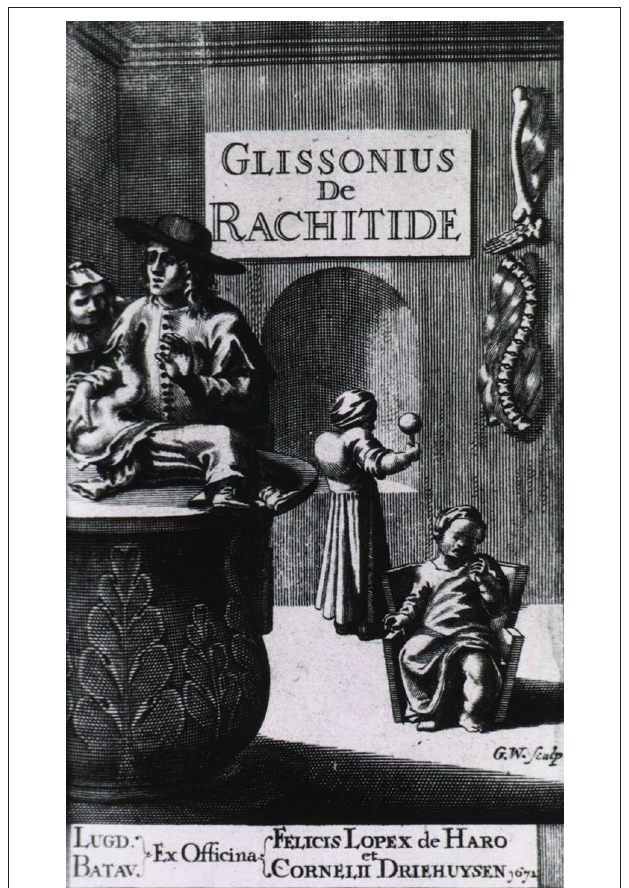
FIGURE 1 | Glissonius de Rachitide—“Glisson examines child with rickets as the mother looks on. Two more children with rickets play in the background and bones deformed by rickets hang on the wall.” The US National Library of Medicine digital collection http://resource.nlm.nih.gov/101434430 (open